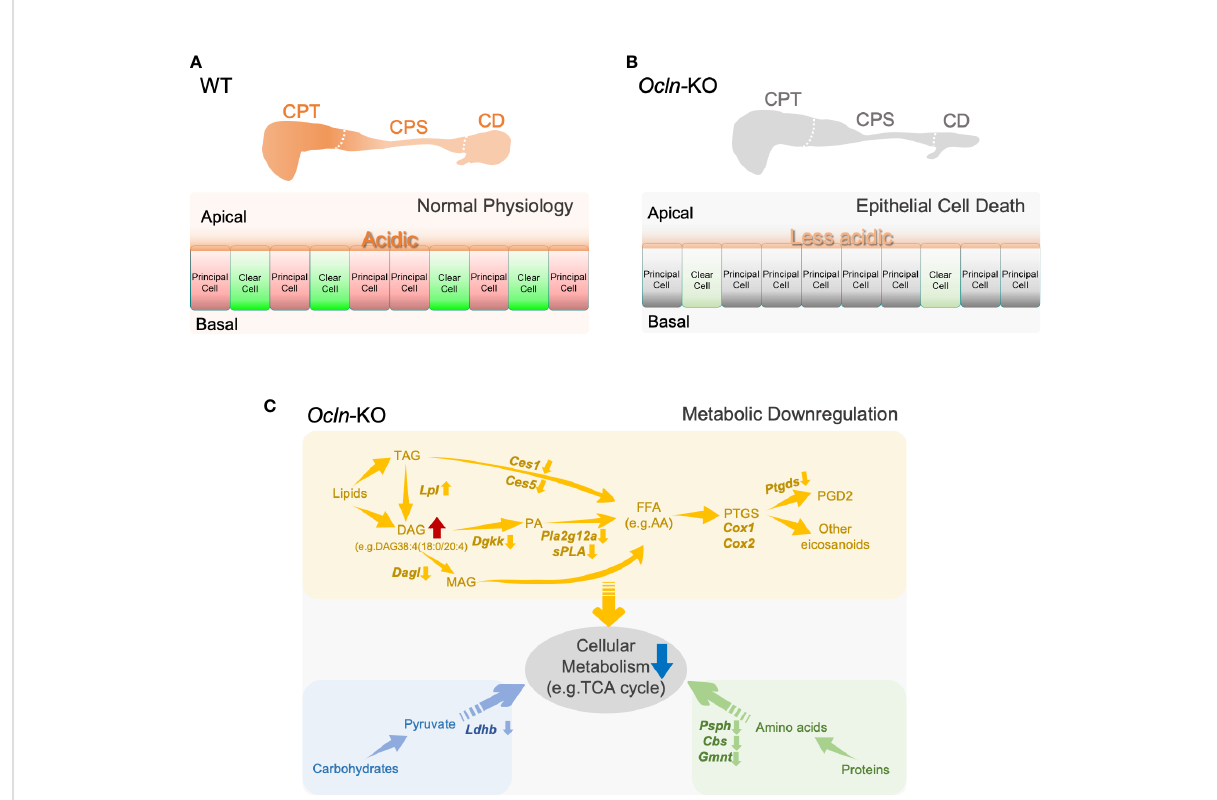
FIGURE 8 Schematic representation of a proposed model for OCLN-promoted acid-secretion and metabolic homeostasis and suggested a role of lipid catabolic enzymes in the mouse epididymis. (A, B) The proposed model of OCLN-promoted epithelial cells survival under normal physiological conditions in WT epididymis or impaired luminal acidi fi cation due to loss of clear cells under pathological conditions in Ocln- KO epididymis. (C) A schematic representation model illustrating the involvement of catabolic enzymes in metabolism in the epithelial cells especially the arachidonic fatty acid and eicosanoid pathways signi fi cantly altered in the Ocln- KO epididymis. AA, arachidonic acid; FFAs, free fatty acids; PTGS, prostaglandin-endoperoxide G/H synthase or COX1/COX2; GPLs, glycerolphospohlipids; PA, phosphatidic acid; LPA, lysophosphatidic acid; DAG, diacylglycerides; MAG, monoacylglycerols; TAG, triacylglycerides. See text for more